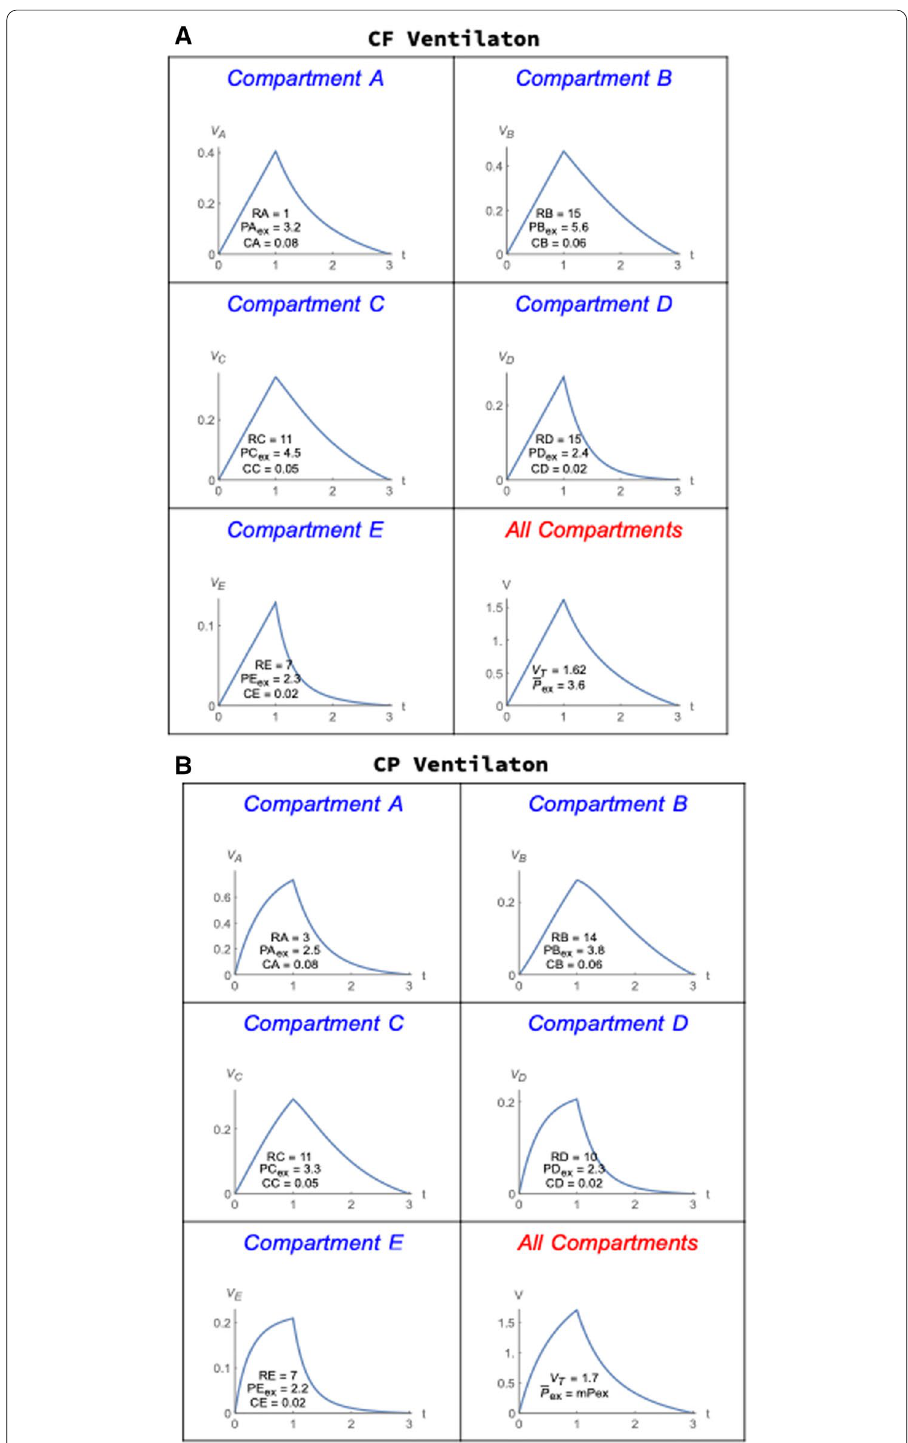
Fig. 2 Compartmental volumes for a single complete tidal cycle of the same volume and inspiratory times during constant inspiratory flow (CF, A ) and constant inspiratory pressure (CP, B ). Note the variations among compartments in end-inspiratory volumes, accompanied by variations in deflation